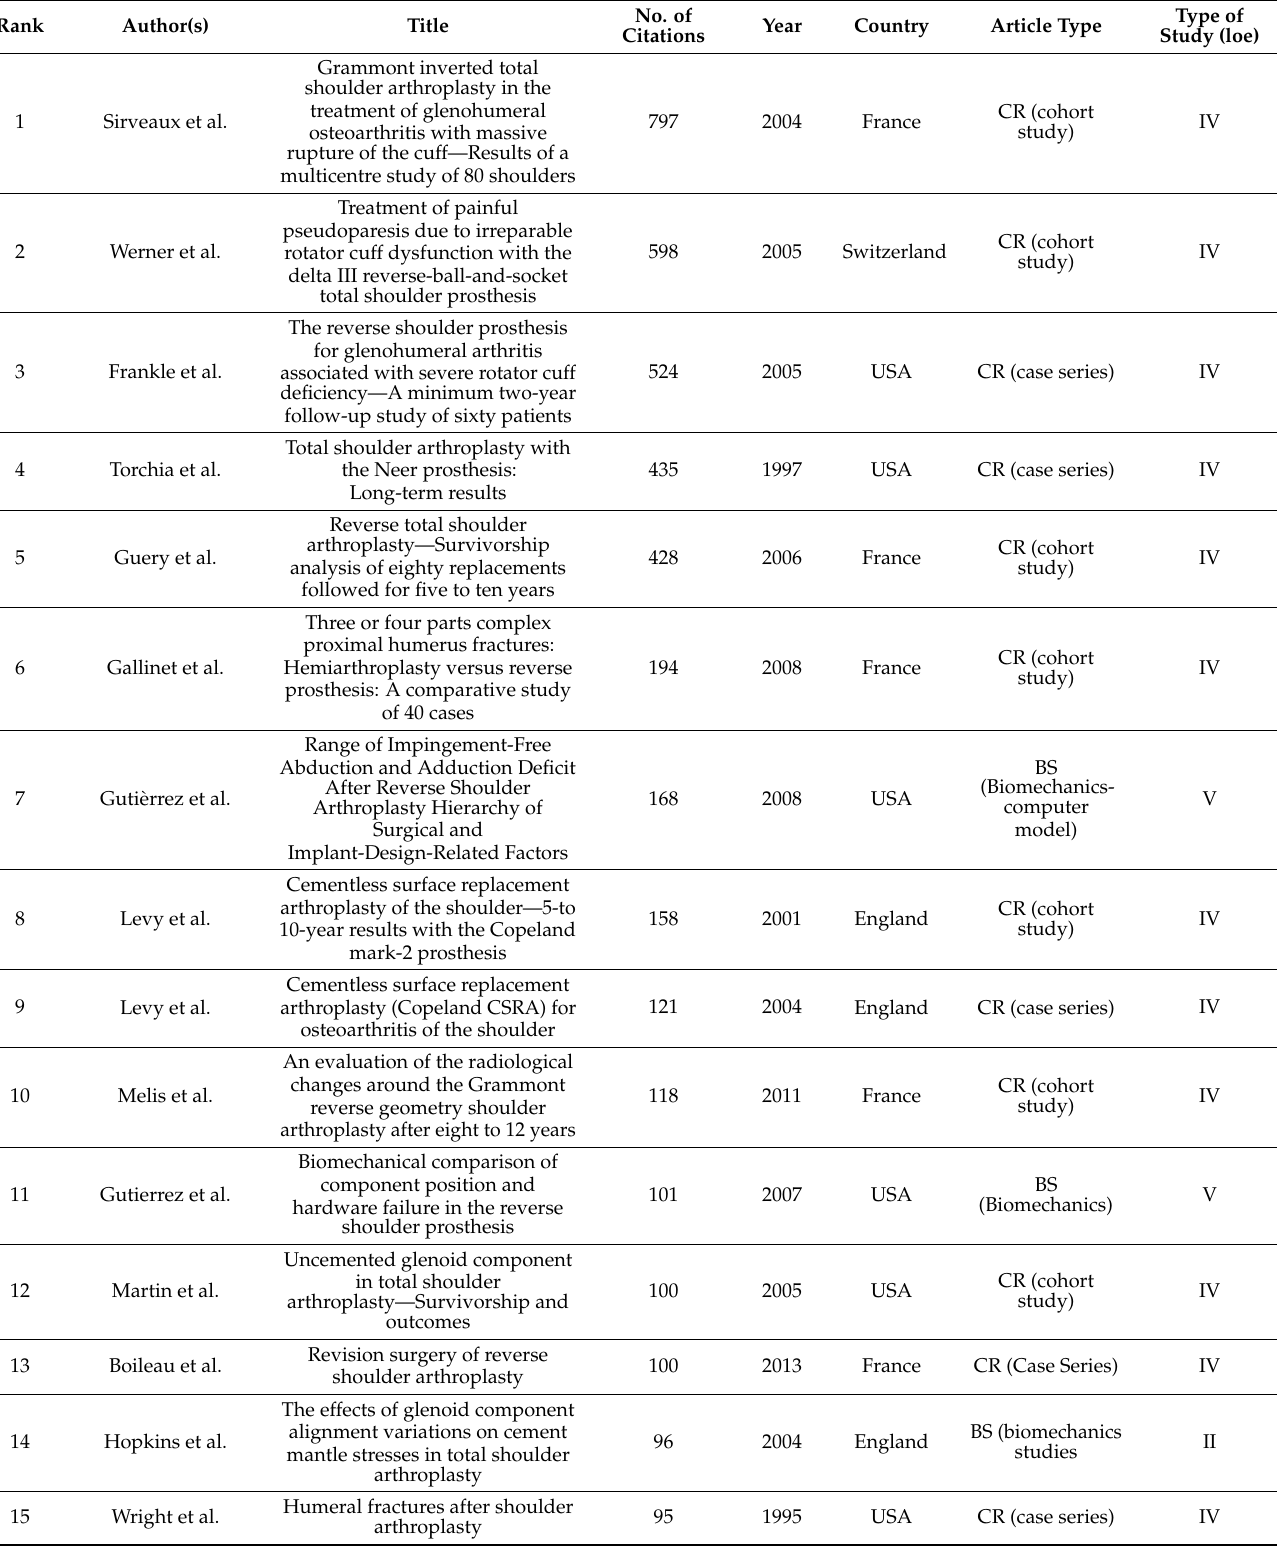
Table 1. Top 50 cited shoulder arthroplasty